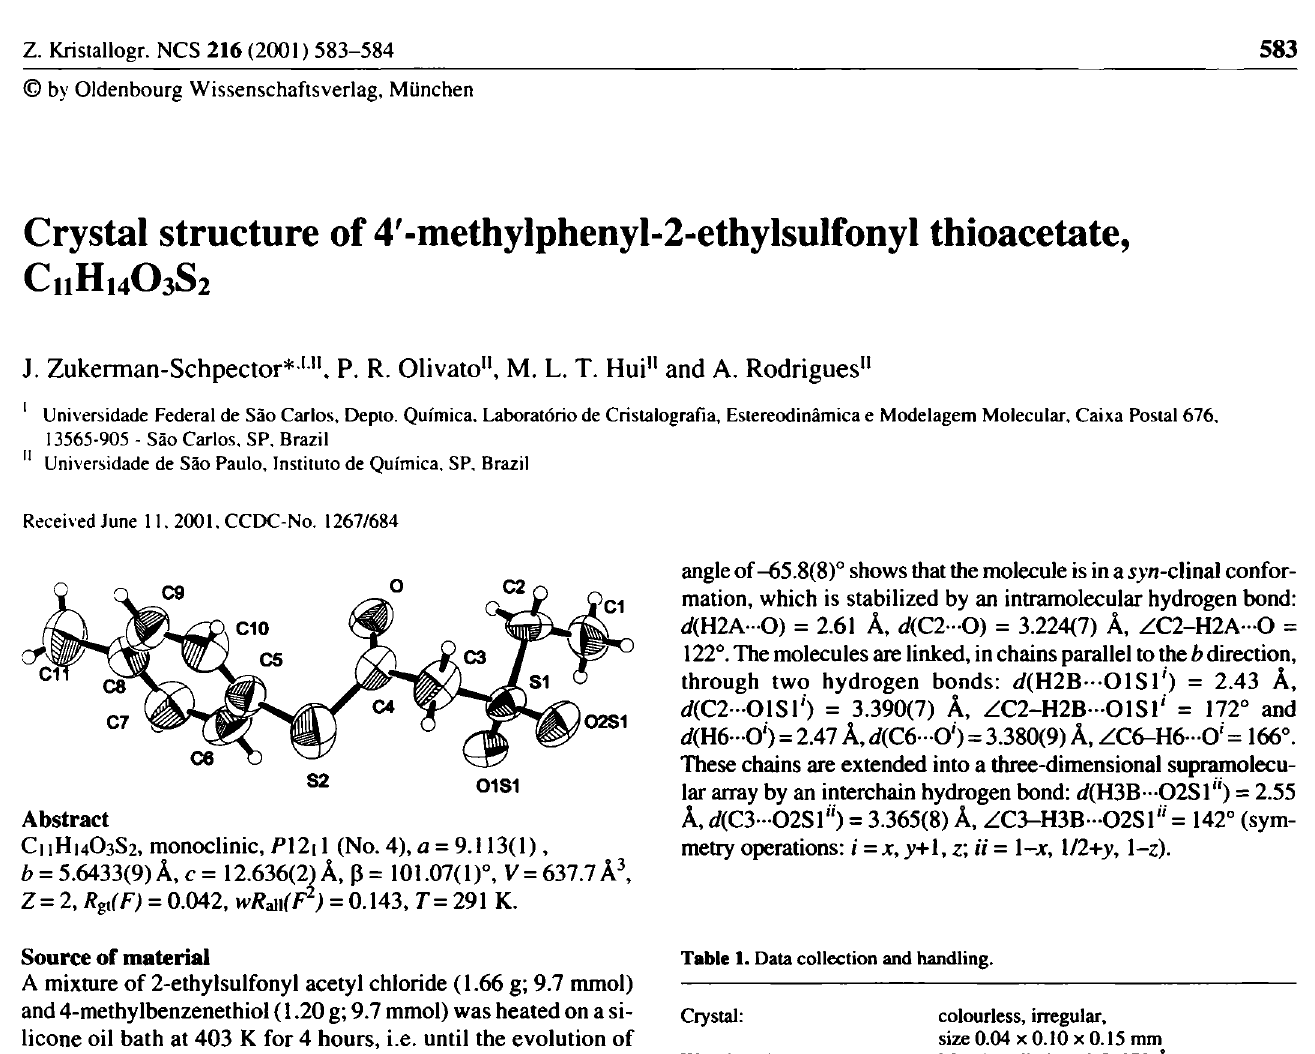
Table 1. Data collection and handling.